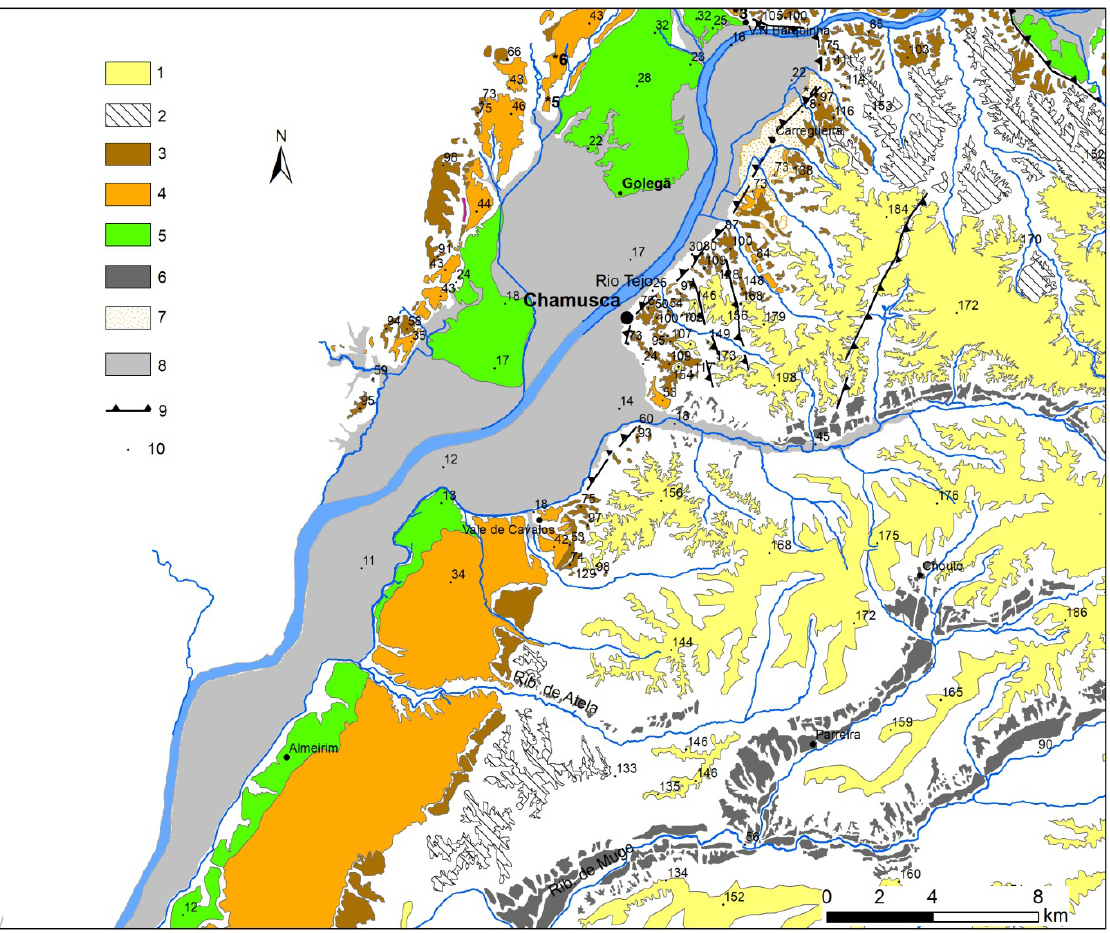
Figura 6. Mapa geomorfológico do sector mais a montante do troço IV do Baixo Tejo. 1 - superfície culminante do enchimento sedimentar da Bacia Cenozóica do Baixo Tejo; 2 - nível de erosão N1; 3 - terraços superiores (T1, T2 e T3); 4 - terraço T4; 5 - terraços inferiores (T5 e T6); 6 - terraços de tributários do Tejo; 7 - cobertura de areias eólicas; 8 - planície aluvial (Holocénico); 9 - escarpa de falha; 10 - ponto cotado (altitude em metros). Figure 6. Geomorphological map of the reach IV (upstream sector) in the Lower Tejo. 1 - culminant surface of the sedimentary infill of the Lower Tejo Cenozoic Basin; 2 - N1 erosion surface; 3 - upper terraces (T1, T2 and T3); 4 - T4 terrace; 5 - lower terraces (T5 and T6); 6 - terraces associated with tributaries of the Tejo River; 7 - aeolian sands; 8 - alluvial plain (Holocene); 9 - fault scarp; 10 - altitude in